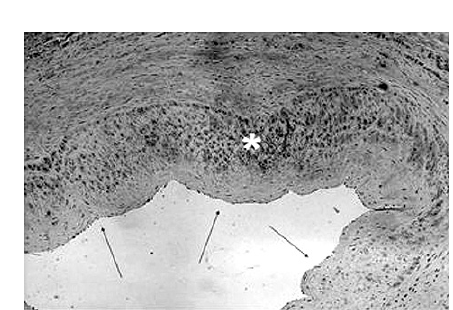
Fig. 3 - Imunohistoquímica da iNOS. As setas indicam a quase nula expressão da iNOS no endotélio da veia safena e o asterisco indica uma exuberante expressão da iNOS na musculatura lisa vascular (100